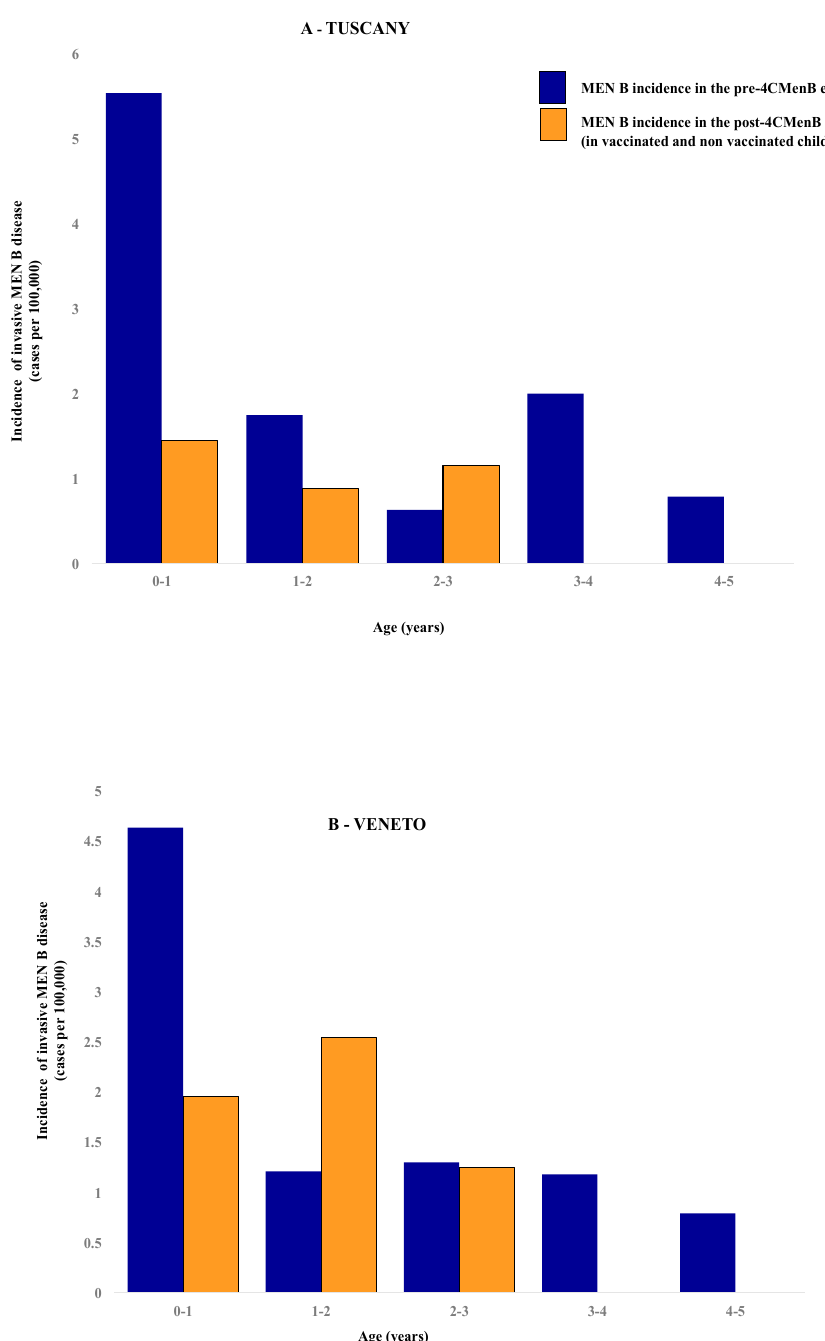
Figure 1. Crude incidences of invasive meningococcal disease in children 0–5 years of age pre and post introduction of 4CMenB in Tuscany ( A ) or Veneto ( B ). In Tuscany, 3 out of 4 cases of Invasive Meningococcal Disease (IMD) and in Veneto 5 out of 7 cases of IMD in the post-4CMenB era occurred in not-vaccinated children. Abbreviations: MenB: Neisseria meningitides serogroup B; 4CMenB = multicomponent meningococcal serogroup B vaccine. With respect to vaccination status, in Tuscany, among four cases found in post-vaccine era, one occurred in an infant vaccinated with two doses of 4CMenB (7 months of age) and three cases were found in non-vaccinated children (respectively, in the first, second and third year of life). In Veneto, among seven cases found in the post-4CMenB era, two cases occurred in vaccinated children